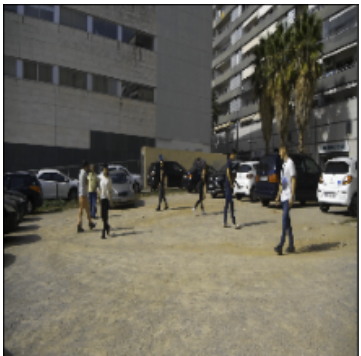
Figure 16. An RGB image of a parking lot shows walking pedestrians.